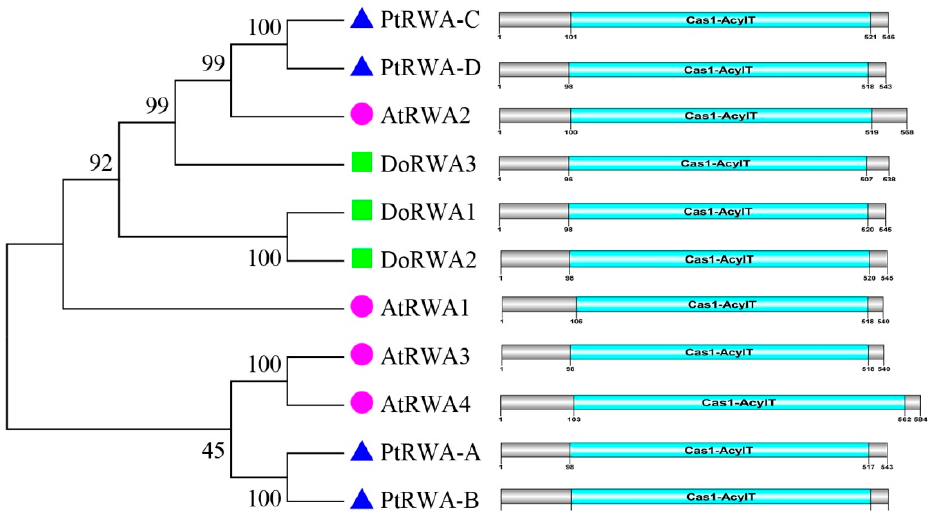
Figure 1. Phylogenetic tree and conserved domain analysis of REDUCED WALL ACETYLATION (RWA) proteins in Dendrobium officinale , Arabidopsis thaliana and Populus trichocarpa . The phylogenetic tree was constructed by the neighbor-joining (N-J) method in MEGA 7.0 software. Domains were drawn by DOG2.0 software. The gene IDs of RWA proteins are: DoRWA1 (MT199223), DoRWA2 (MT199224), DoRWA3 (MT199225), AtRWA1 (At5g46340), AtRWA2 (At3g06550), AtRWA3 (At2g34410), AtRWA4 (At1g29890), PtRWA-A (Potri.001g352300), PtRWA-B (Potri.011g079400), PtRWA-C (Potri.010g148500), and PtRWA-D (Potri.008g102300). The blue area indicates the Cas1-AcylT conserved domain.